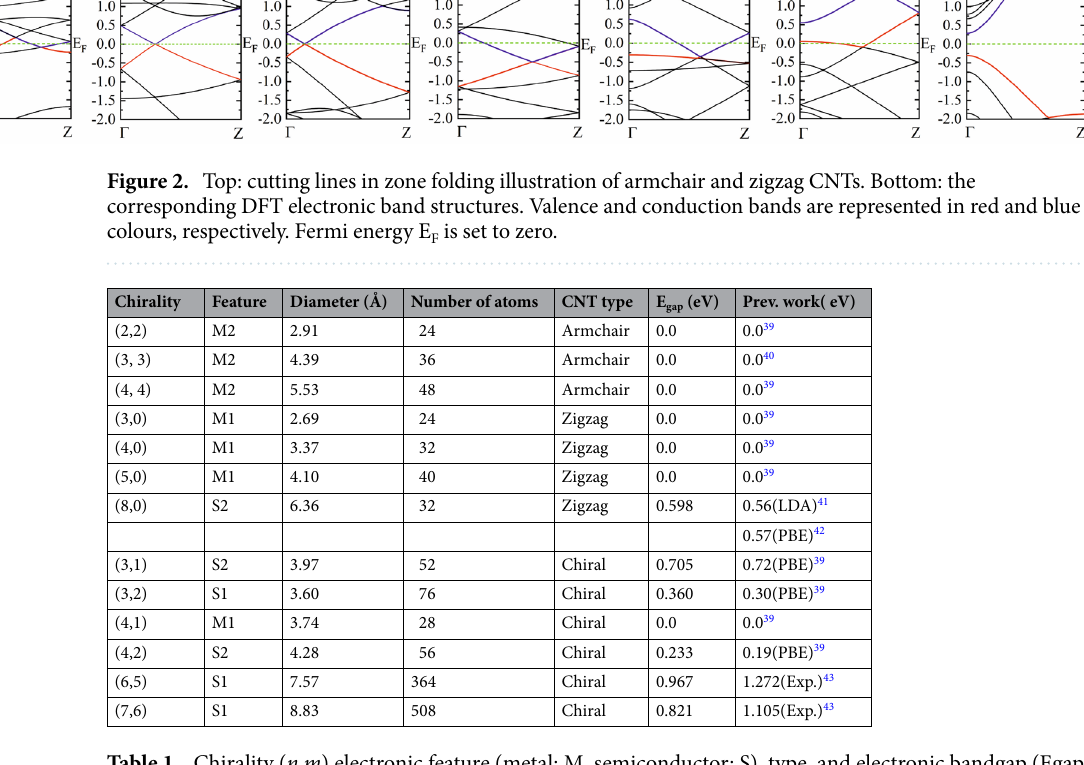
Table 1. Chirality ( n , m ),electronic feature (metal: M, semiconductor: S), type, and electronic bandgap (Egap) of pristine CNTs. Band gaps are compared with the previous data.